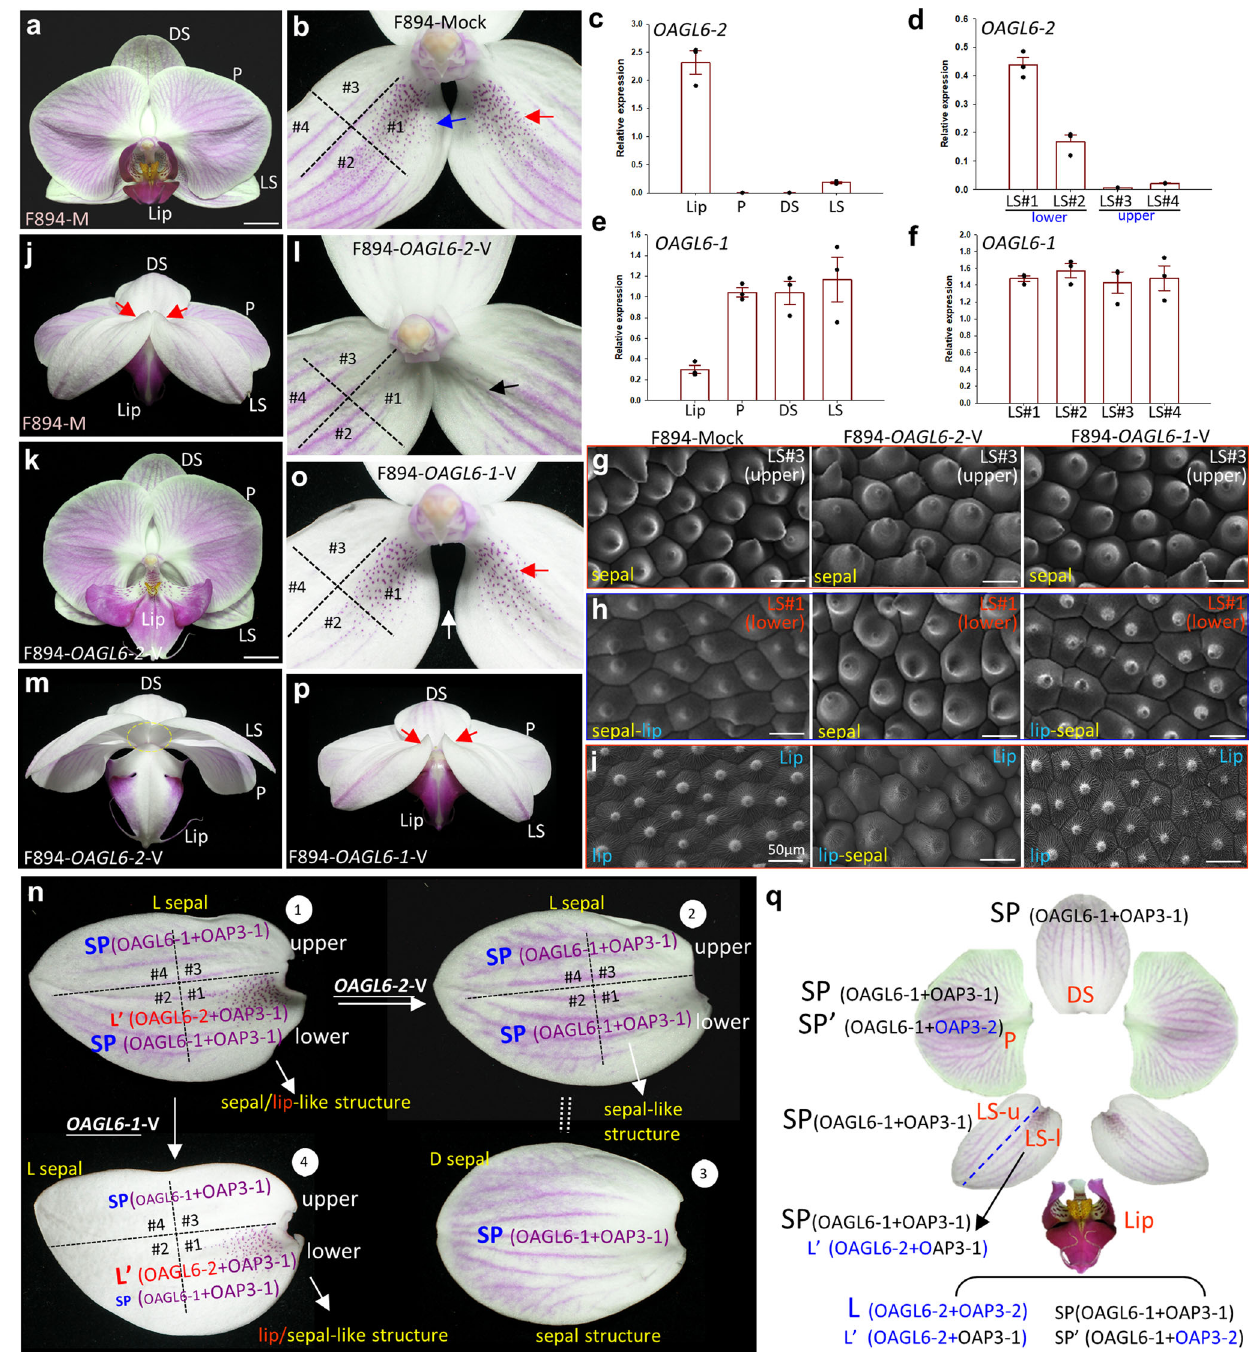
reduced in the OAGL6-1 -VIGS, OAP3-1 -VIGS F894 and OPI - VIGS dorsal/lateral sepals, similar to that in the PeMYB12 -VIGS F894 fl owers (Fig. 2i). Since only OAGL6-1 , OAP3-1 and OPI in SP complex expressed in the dorsal/lateral sepals, indicating that the SP complex (OAGL6-1 + OAP3-1 + OPI) is exclusively required for anthocyanin accumulation in dorsal/lateral sepals by activating the PeMYB12 expression (Fig. 2j). Silencing of either OAGL6-1 , OAP3-1 or OPI expression caused the same disruption of the SP complex and the reduction in pigmentation in dorsal/ lateral sepals (Fig. 2b, c, left 3 to 5). In contrast, silencing of OAGL6-2 or OAP3-2 expression in the L complex did not affect the pigmentation (Fig. 2a, b, c, left 7 and 8) in the dorsal/lateral sepals.